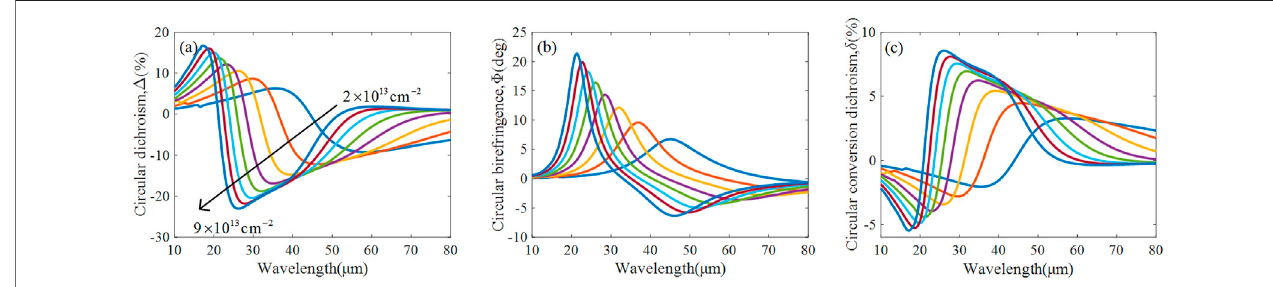
FIGURE 3 | In fl uences of the doping concentration level on the chiral responses of the square BP metamaterial. The doping concentration level changes from 2 × 10 13 cm − 2 to 9 × 10 13 cm − 2 with a step of 1 × 10 13 cm − 2 . (A) Circular dichroism Δ , (B) circular birefringence Φ , and (C) circular conversion dichroism δ .